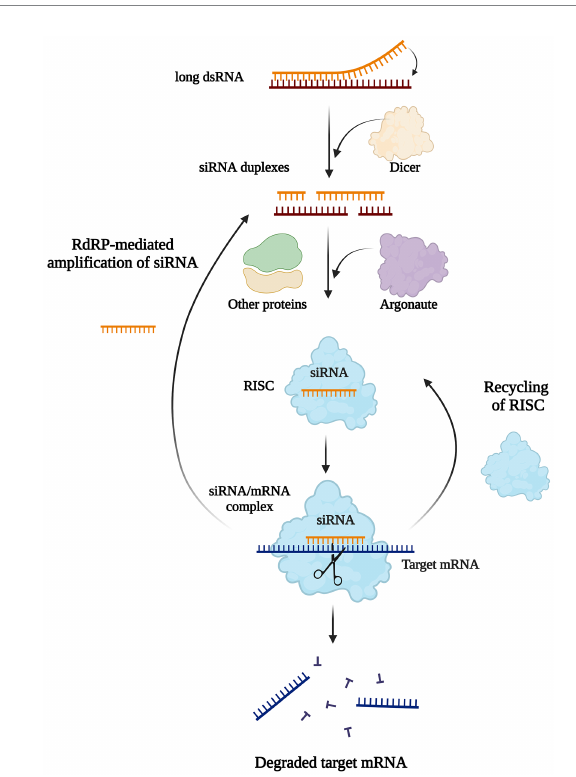
FIGURE 5 Biological mechanisms of RNAi-mediated gene silencing. Long double-stranded RNAs or hairpin RNAs bind to Dicer are cleaved, and then generate multiple 21–23 bp double-stranded small interfering RNAs (siRNAs) duplexes. Each siRNA is unchained into a passenger (sense) strand and a guide (antisense) strand by intracellular RNA helicase. The guide strand binds with Argonaute (AGO) and other proteins to form an RNA Induced Silencing Complex (RISC), while the passenger strand is degraded by subsequent cellular events in the cytoplasm. The siRNA/RISC complex then binds the complementary mRNA resulting in the degradation of the target transcript or inhibition of translation. The components of siRNA/mRNA complex can be recycled to the RISC complex or generate siRNA duplexes by the action of RNA- dependent RNA Polymerase (RdRP).